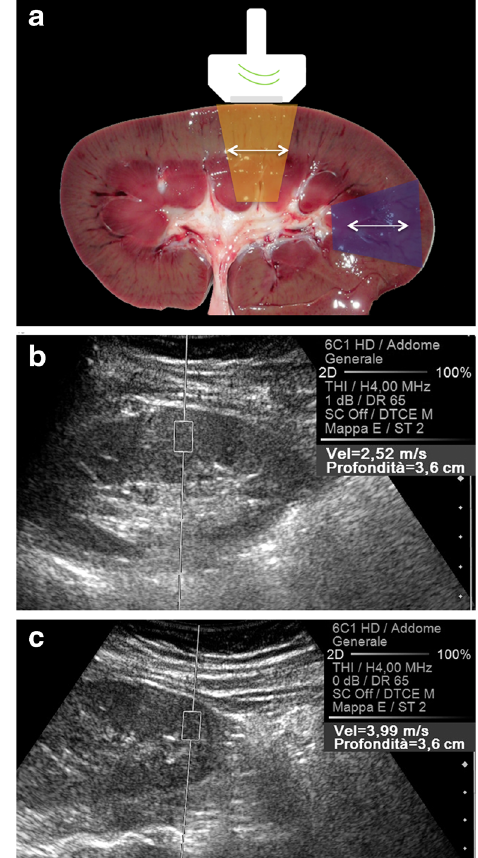
Fig. 9 Effect of anisotropy on the speed of propagation of the shear waves. When the axis of the main US beam is parallel to the orientation ofthevasarecta and Henle loops ( orangebox in a ), theshear waves travel perpendicular to these structures and then move slowly (2.52 m/s in b ). In the opposite condition ( blue box in a ), the SWV is higher (3.99 m/s in c )